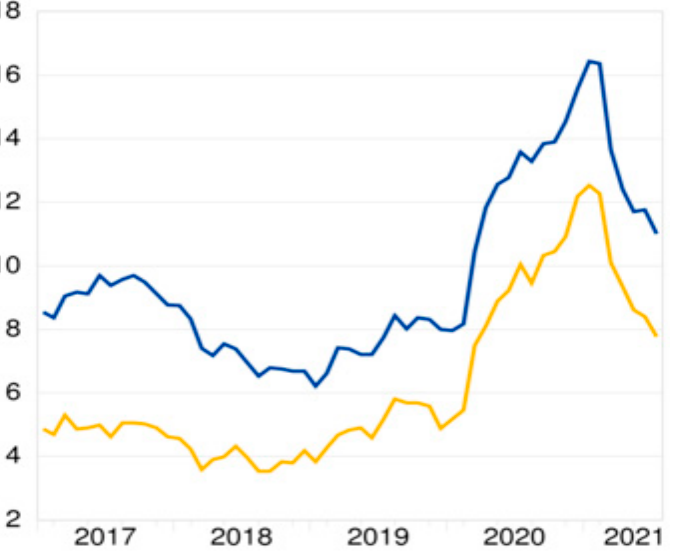
Figure 1. Euro monetary aggregates’ M1 (blue) and M3 (yellow) annual growth rate. Source: ECB. In the first half of 2020, the coronavirus pandemic shock (COVID-19) and the subse- quent lockdowns struck the Euro area economy (European Central Bank 2020). Central bank liquidity in the banking system increased by EUR 2.2 trillion, introducing a temporary pandemic emergency purchase program (PEPP), relaxing eligibility and collateral criteria and offering new pandemic, longer-term refinancing operations (PELTROs). All this contributed to re- ducing risk premia and stabilizing the economy.